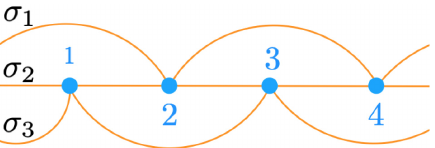
FIG. 13. A configuration of intersecting paths, corresponding to a configuration of domain walls in the S 4 lattice magnet is shown. Here, σ 1 σ 2 σ 3 = ( 1 2 3 4 ) , and each domain wall σ i is an elementary transposition. The intersection points alternate between either the top or the bottom path intersecting the middle path at the points labeled in